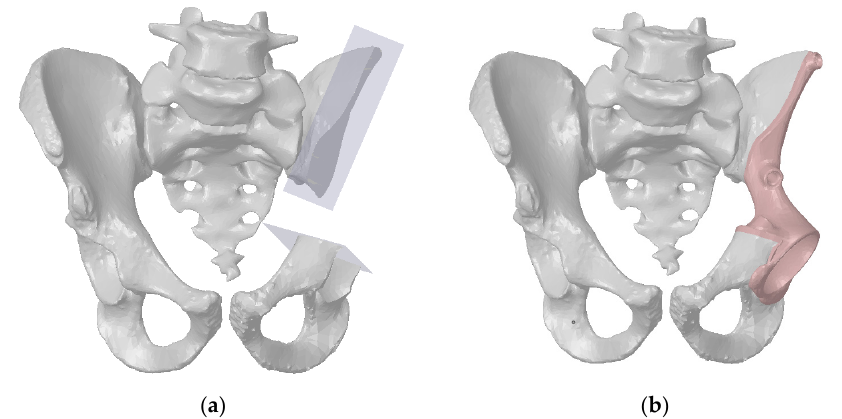
Figure 1. A virtual resection of the pelvic bones for pelvic tumour surgery: ( a ) resection planes; ( b ) the pelvis reconstructed with the individual endoprosthesis.